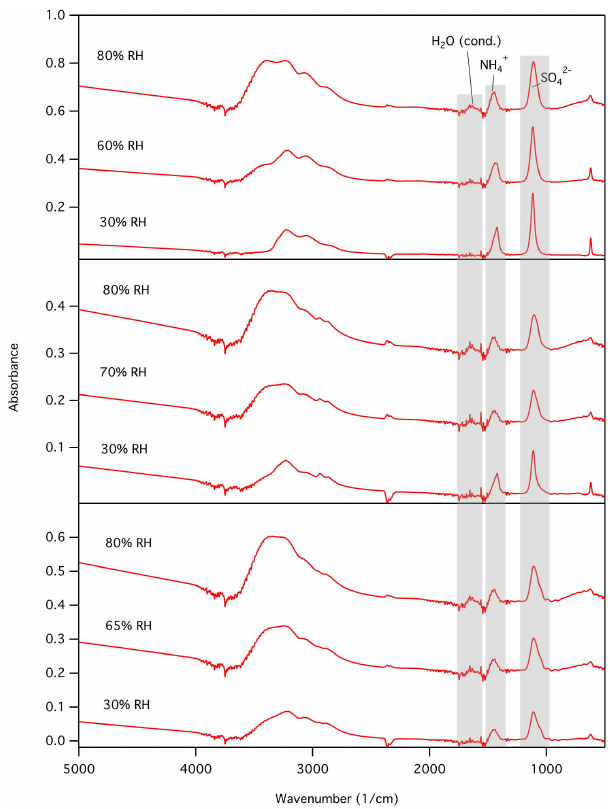
Figure 4. Spectra obtained after subtraction of gas-phase wa- ter features. Top panel: ammonium sulfate, middle panel: 1 : 1 (NH 4 ) 2 SO 4 / 1,2,6-hexanetriol (mixture by mass), bottom panel: 1 : 1 (NH 4 ) 2 SO 4 / glycerol. Note the presence of a condensed-phase water feature at 1640cm − 1 (the HOH bend). This was used to quan- tify liquid water in the aerosol phase.